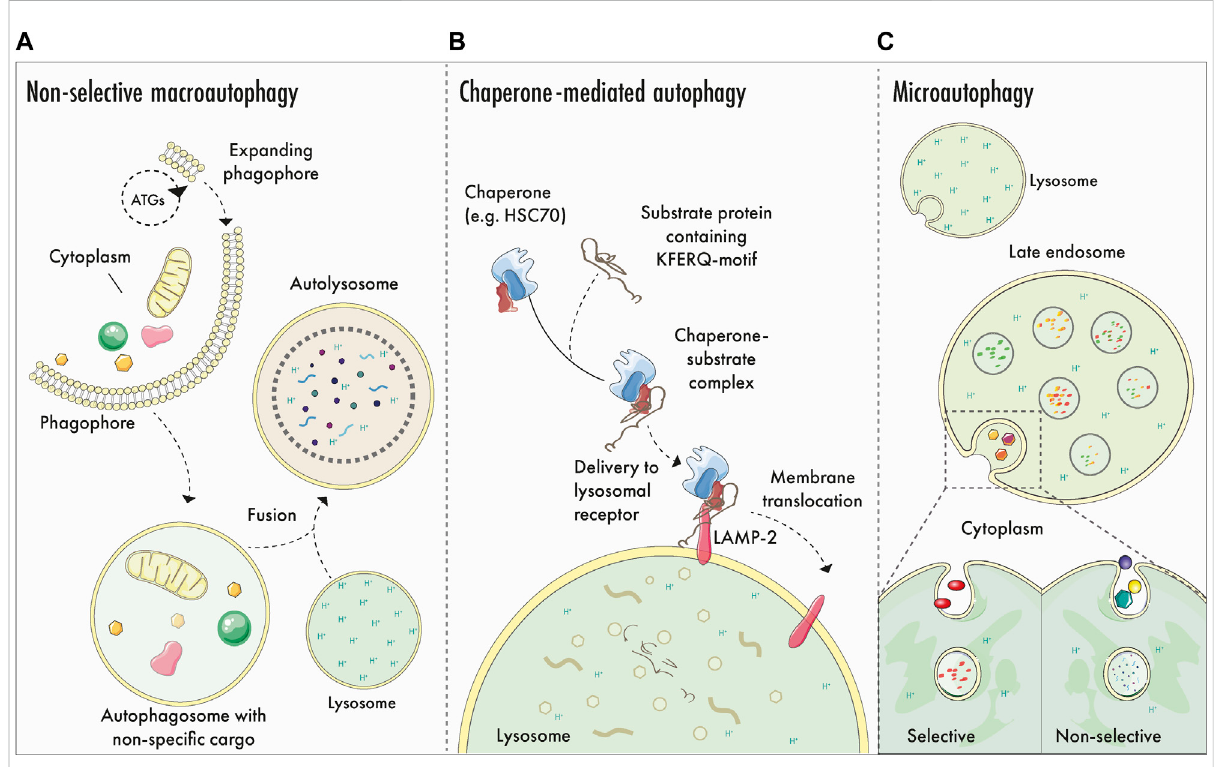
FIGURE 1 Generalisedautophagylogistics:macroautophagy,CMAandmicroautophagy. (A) – Non-selectivemacroautophagy:ATGproteinsparticipatein phagophore biogenesis and expansion, generating a double membrane structure that encapsulates portions of cytoplasmic matter. Leading edges oftheexpanding phagophore undergo abscission to formtheautophagosome, whichmatures andeventually fuses with anacidic endolysosometo yield an autolysosome. Cargo is degraded by hydrolytic enzymes originating from the lysosome and is recycled to fuel cellular anabolism and signalling. (B) – Chaperone mediated autophagy (CMA): CMA involves the selective sequestration of proteins containing a KFERQ-motif. Here, cytosolic proteins are recogniced by chaperones that mediate the transportation to the lysosomal membrane, where the transmembrane receptor LAMP-2 binds to and translocates the cargo into the lysosomal lumen for elimination. (C) – Selective and non-selective microautophagy. Cytosolic cargo is degraded selectively or non-selectively via lysosomal or late endosomal membrane invagination and internalisation. Once internalised, lysosomal hydrolytic enzymes degrade the